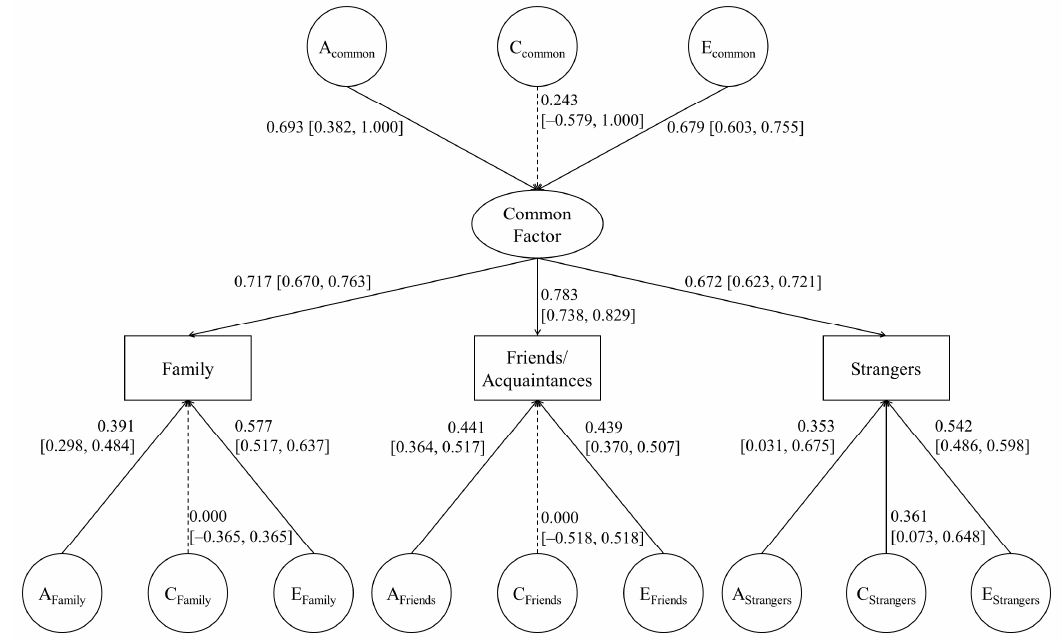
Figure 1. Common pathway model of altruism. A common , C common and E common represent additive genetic factor and non-shared environment in the common pathway model. A Family , C Family , E Family , A Friends , C Friends , E Friends , A Strangers , C Strangers , and E Strangers represent specific A, C, and E factors of altruism for family, friends/acquaintance and others.